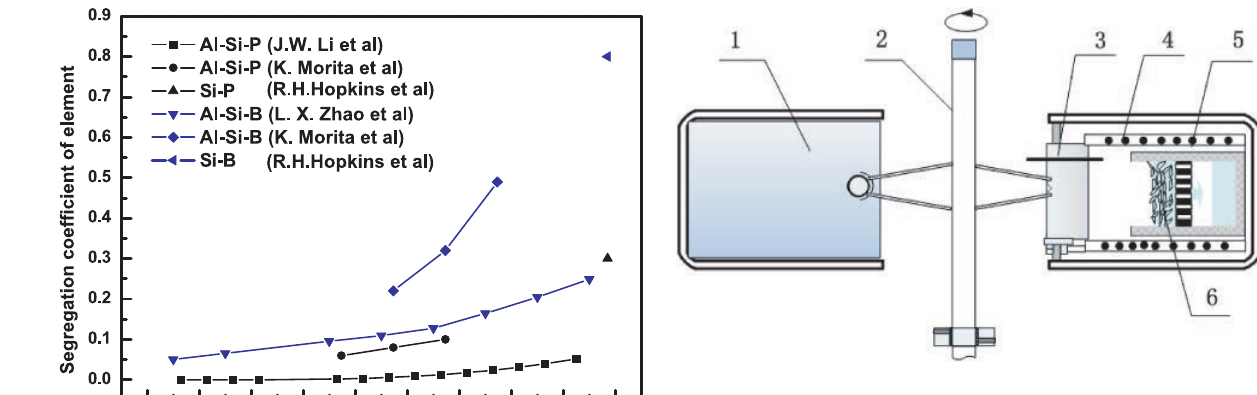
Fig. 2: Schematic sketch of the experimental centrifugal apparatus. 1. Counterweight; 2. Centrifugal axis; 3. Thermocouple; 4. Resistance coil; 5. Alumina filter; 6. Specimen